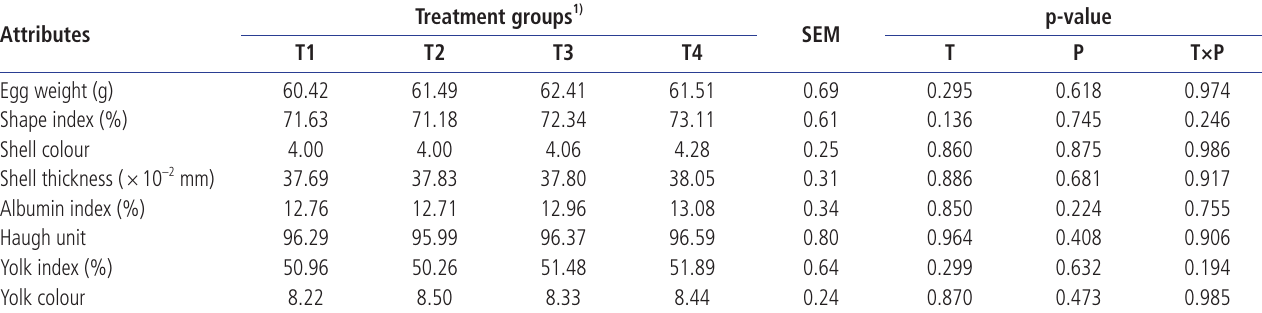
Table 3. Effect of soapnut shell powder supplementation on egg quality of broiler breeders